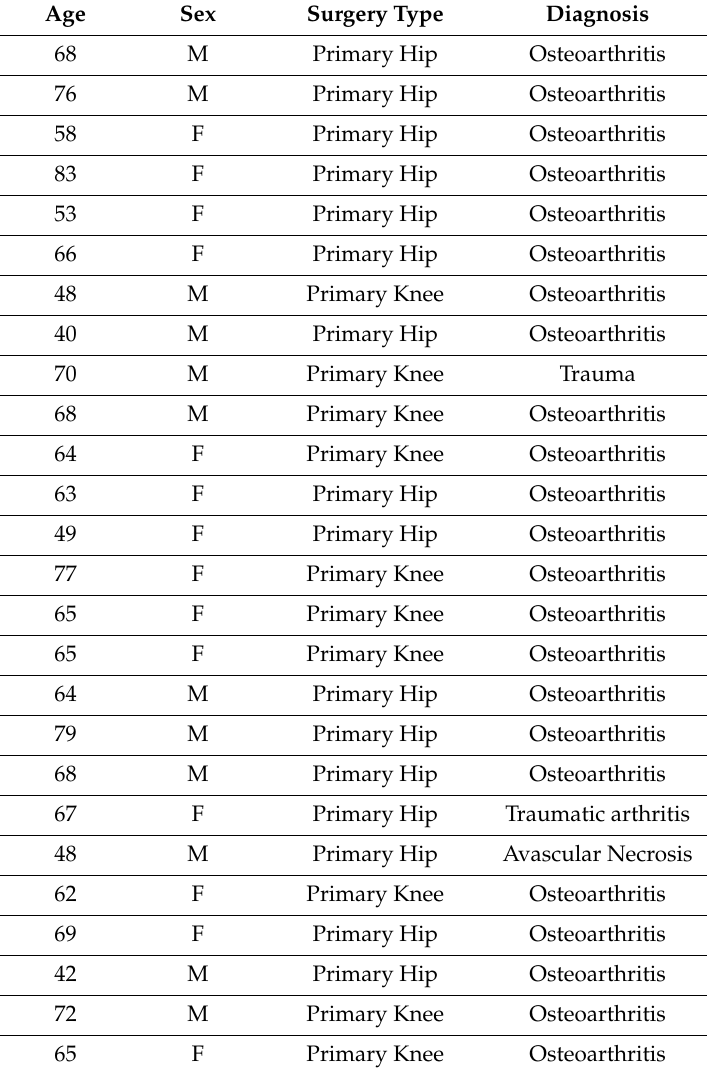
Table 1. Hip and knee arthroplasty